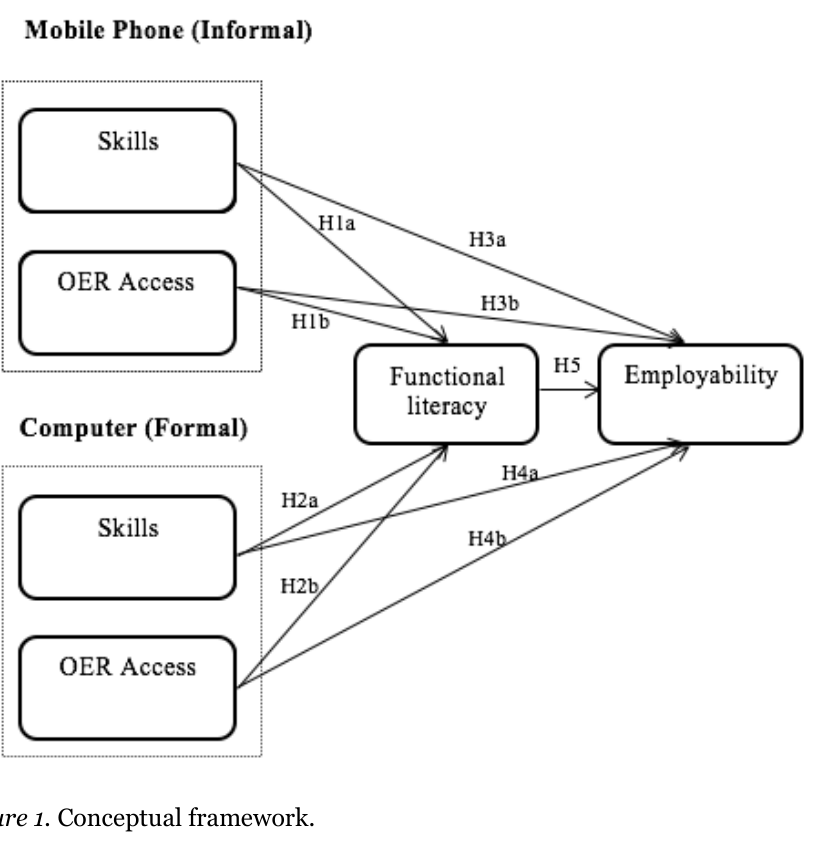
Figure 1. Conceptual